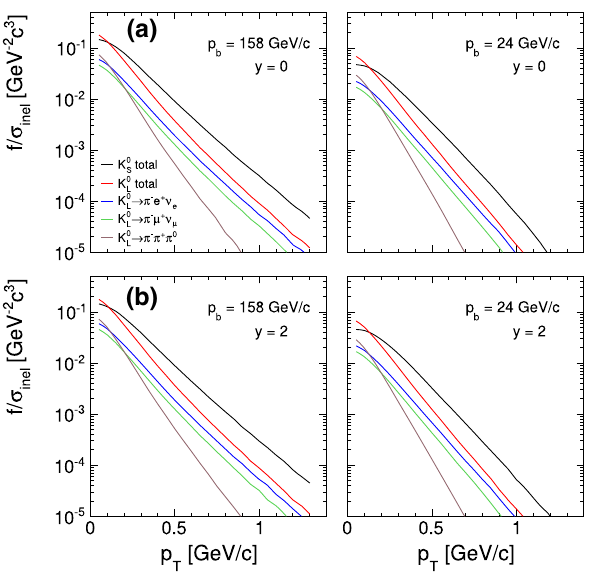
Fig. 17 Invariant π − crosssectionsasafunctionof p T forthedifferent K 0 decays (18) and the corresponding total yield compared to the K 0 L decay a y = 0 and b y = 2 at p beam = 158 and 24